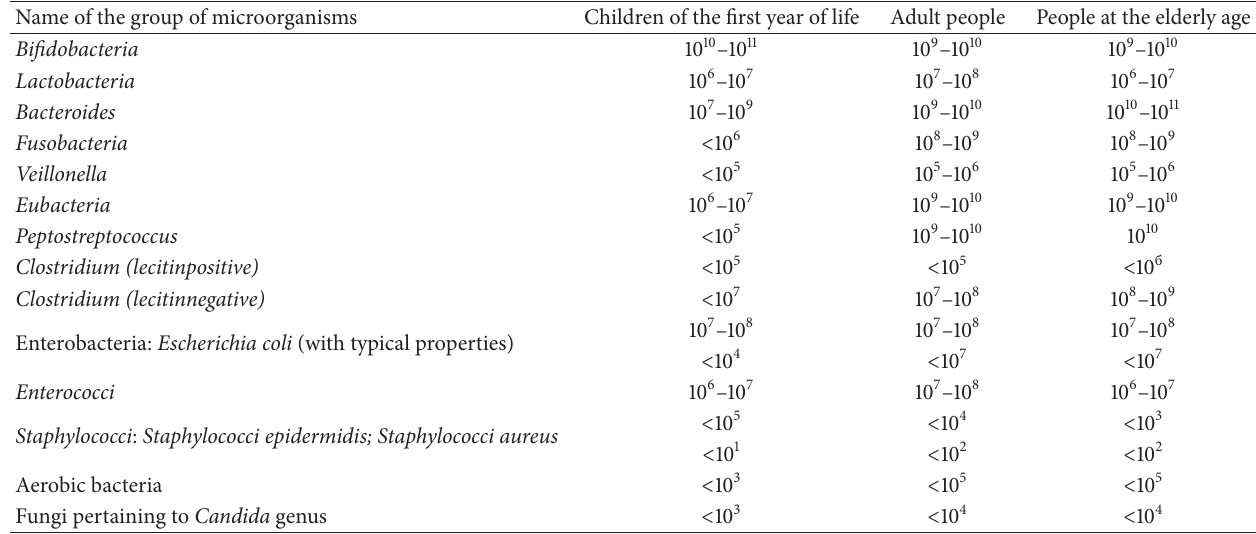
Table 3: Composition of intestine microflora in various age